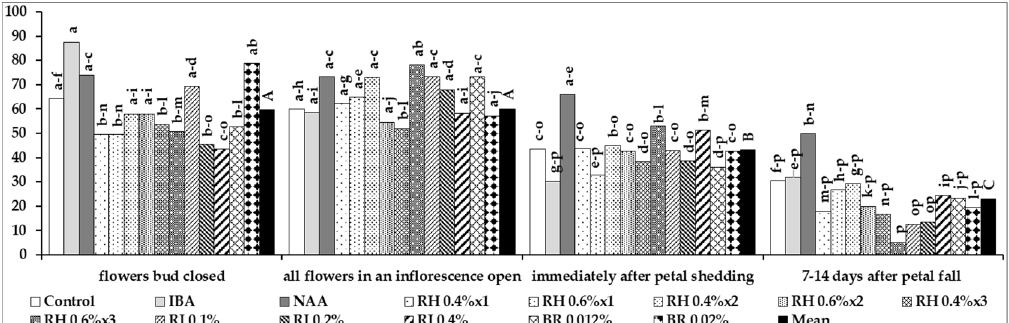
Figure 4. The influence of rooting enhancers on percentage of rooted cuttings with retained stock plant leaf (%) of Rosa ‘Maiden’s Blush’ harvested in four phenological stages of shoot. Control—the control cuttings; IBA 0.4%—Ukorzeniacz A aqua (0.4% IBA); NAA 0.2%—Ukorzeniacz B aqua (0.2% NAA); RH 0.4%×1, RH 0.6%×1—watering with 0.4% or 0.6% Bio Rhizotonic (10 mL) after planting; RH 0.4%×2, RH 0.6%×2—watering with 0.4% or 0.6% Bio Rhizotonic (10 mL) after planting and 10 days later; RH 0.4%×3, RH 0.6%×3—watering with 0.6% Bio Rhizotonic (10 mL) after planting, 10 and 20 days later; RJ 0.1%, RJ 0.2%, RJ 0.4%—watering with 0.1%, 0.2% or 0.4% Root Juice™ (10 mL) after planting; BR 0.012%, BR 0.02%—watering with 0.012% or 0.02% Bio Roots (10 mL) after planting. Different small letters indicate significant interactions between phenological stage and treatment (two ‐ way ANOVA). Different capital letters indicate significant differences between phenological stages. The Duncan’s test ( α = 0.05) was used.